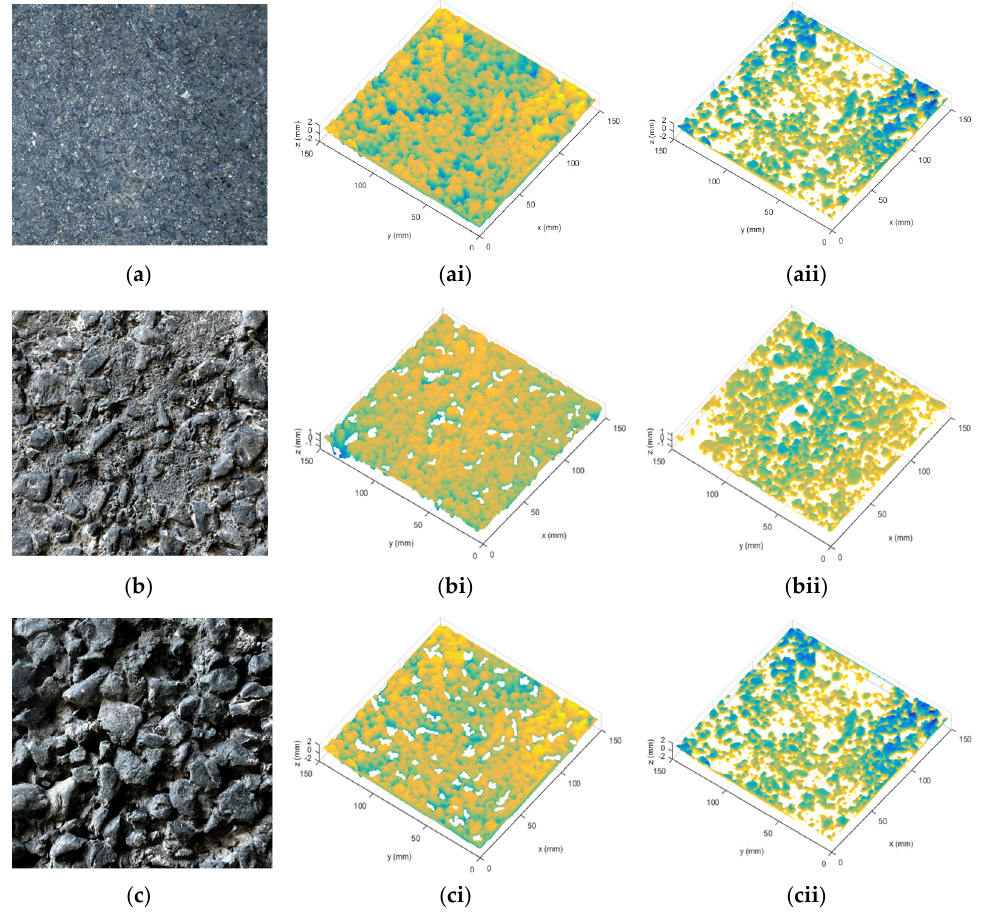
Figure 2. Pavement texture visualization under different conditions: ( a ) AC − 13 pavement in ( ai ) dry conditions and ( aii ) wet conditions; ( b ) SMA − 13 pavement in ( bi ) dry conditions and ( bii ) wet conditions; ( c ) OGFC − 13 pavement in ( ci ) dry conditions and ( cii ) wet conditions. Notes: AC = dense-graded asphalt pavement; SMA = stone matrix asphalt; OGFC = open − grade friction